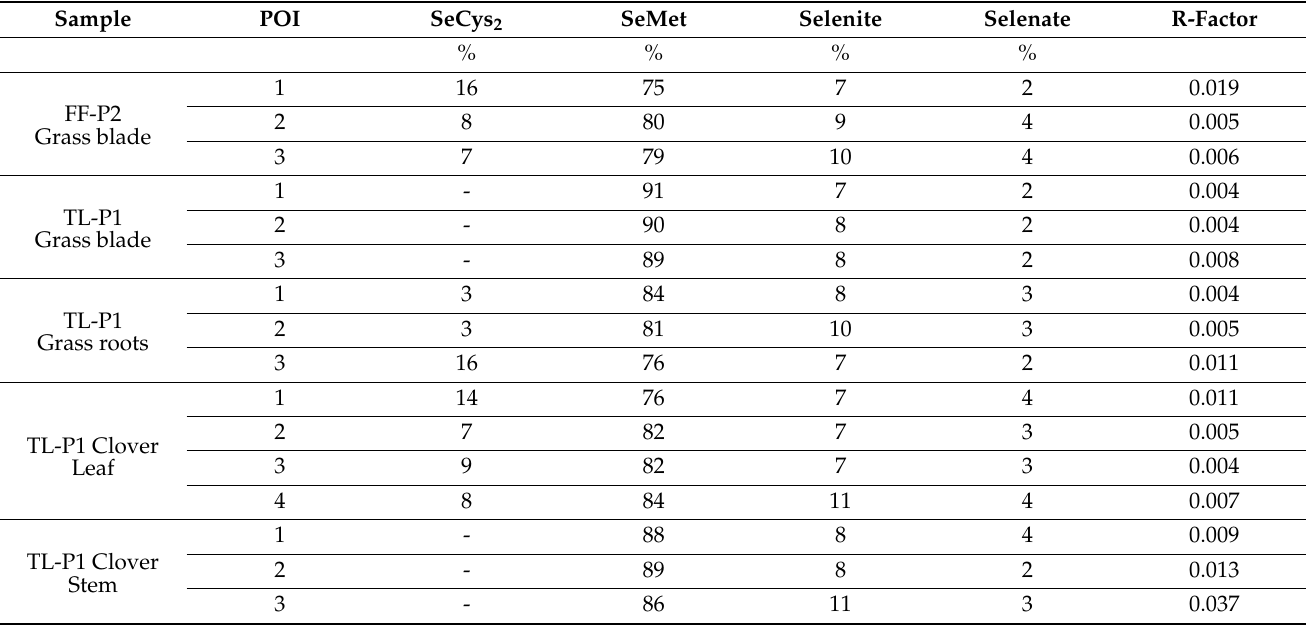
Table 6. Linear combination fits for selected selenium non-accumulator species measured in ATHENA. The goodness of fit is determined by the R-factor. The improvement in the fit for values <4% is marginal.